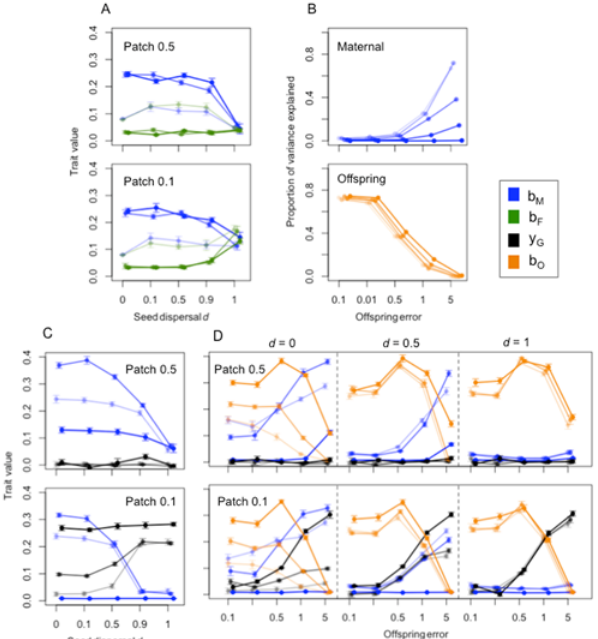
Figure 3. Plant model results. (A, C, D) Mean ± SE evolved values from the last 20,000 generations for each loci for simulations where environments are equally common (top) or one patch is rare (bottom); and (B) proportion of variance explained by maternal (top) or offspring (bottom) environment using analysis of variance of the trait liability y (as explained in S2 File). Blue points represent values for maternal input b b b M (A, C, D), green points, paternal input F (A), orange points, offspring input O (D) and black points, genetic input y G (B, D). Separate lines of increasing darkness represent increasing levels of pollen dispersal (A) or parental trait distribution (B-D). Values are provided in separate panels for three levels of seed dispersal in panels of plot D. The patterns in B are qualitatively similar if the evolved values are plotted (see Figure C in S2